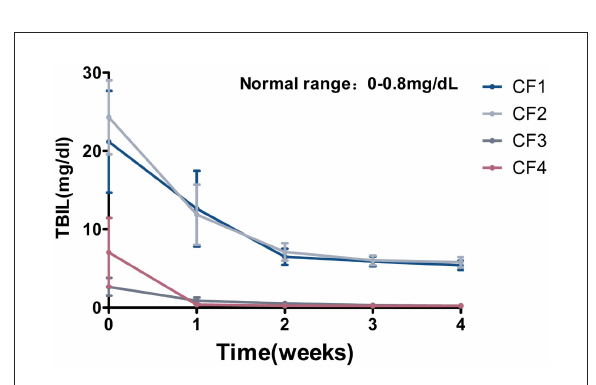
FIGURE7 Mean TBIL changes and standard error for 4 groups cats that completed 4 weeks of treatment. TBIL, total bilirubin.